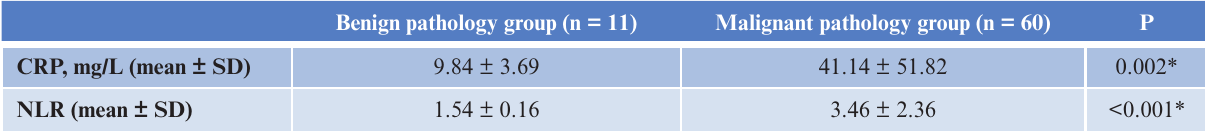
Table 2: Comparison of serum C-reactive protein and neutrophil-to-lymphocyte ratio levels between the groups.